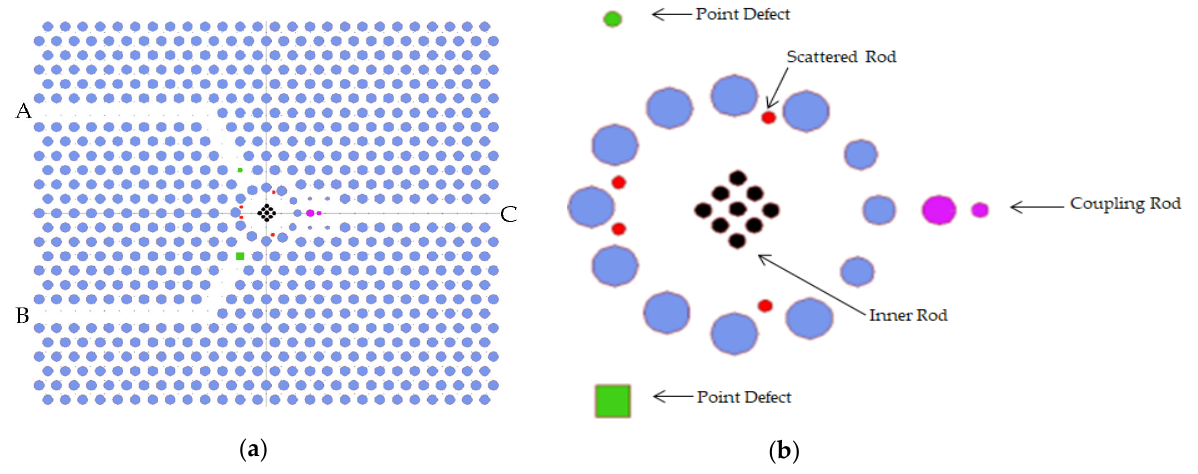
Figure 1. ( a ) The structure model of 2D photonic crystal THz wave modulator. ( b ) Sectional view of combined microcavity. Table 1. Structure model parameters of photonic crystal THz modulator.